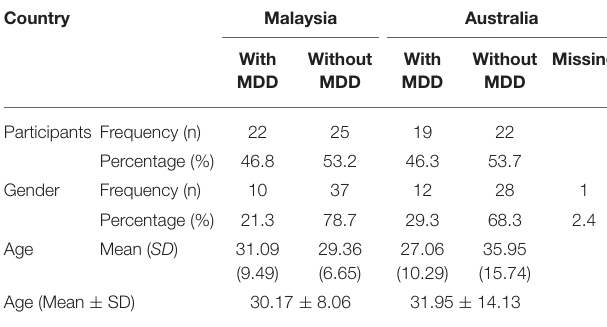
TABLE 1 | Demographic data of